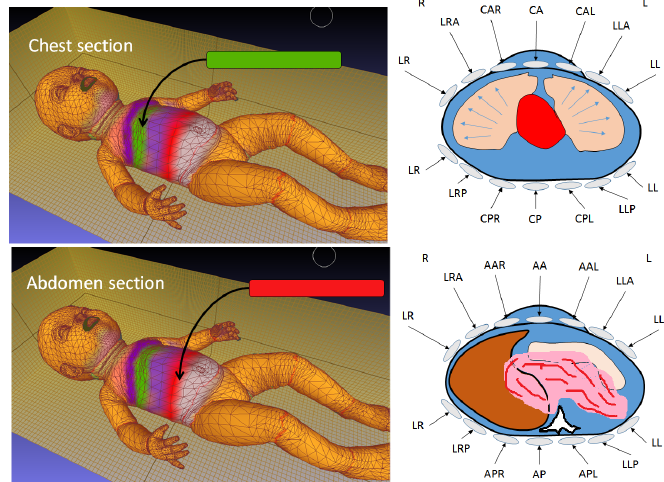
Figure 14. Experimental setup for CGI used in the detection and identification of respiratory and pulmonary functions by using a clinical inductive belt positioned at two levels (upper and lower) to generate several color-coded regions via CGI-vertex meshing colorization to indicate displacement and mechanical distortion due to several physiological- and pathological-related events.